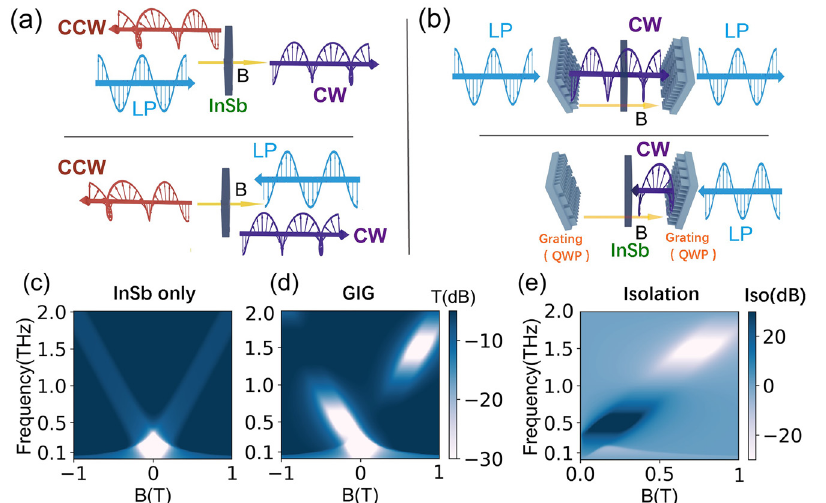
Figure 1: Schematic diagram of THz nonreciprocal one-way transmissionbased on InSb: the forward and backward LP waves incident into (a) the longitudinally magnetized InSb and (b) the InSb sand- wiched in between two orthogonal meta- gratings. The theoretically calculated transmittance map as a function of fre- quency and the MF for the LP incidence of (c) the bare InSb and (d) GIG structure. (e) The calculated isolation for the LP inci- dence of GIG structure. In all the calcula- tions, the carrier density of InSb is set to 4 × 10 14 cm − 3 as the temperature is 80